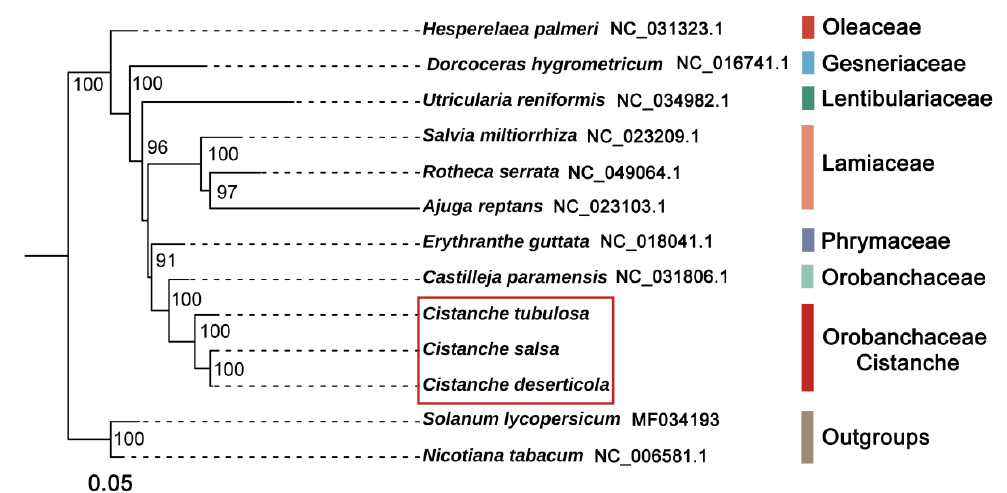
Figure 4. Phylogenetic relationships of Cistanche species with 8 other Lamiales species. The tree was constructed based on the amino-acid sequences of 49 mitochondrial protein-coding genes, including atp 1, atp 4, atp 6, atp 8, atp 9, atp B, atp E, ccmB , ccmC , ccmFc , ccmFn , cob , cox 1, cox 2, cox 3, cyt B, Itr A, matR , mttB , nad 1, nad 2, nad 3, nad 4, nad 4L, nad 5, nad 6, nad 7, nad 9, pet G, pet L, rbc L, rpl 2, rpl 5, rpl 10, rpl 16, rpl 23, rpl 36, rps 1, rps 3, rps 4, rps 7, rps 10, rps 11, rps 12, rps 13, rps 14, rps 19, sdh 3 and sdh 4. Species in red box were three Cistanche species.